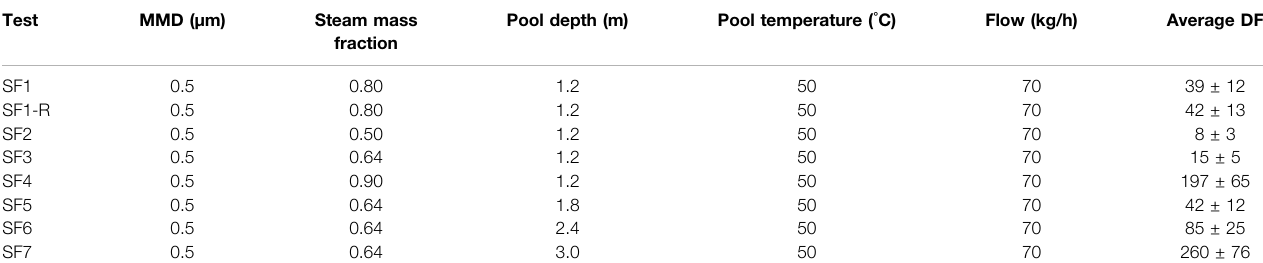
TABLE 1 | Average DF for each test.